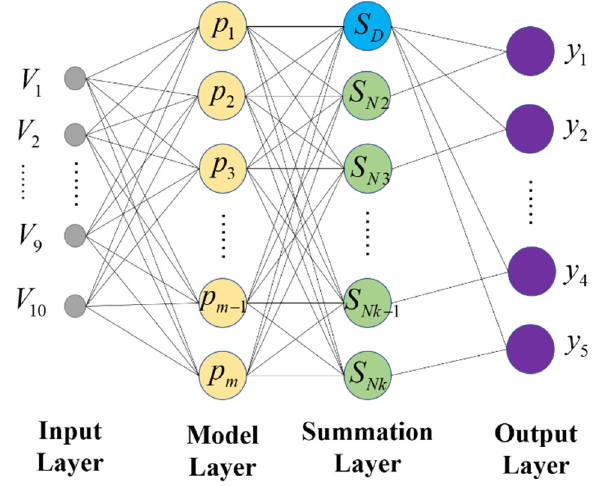
Figure 6. The structure diagram of GRNN.